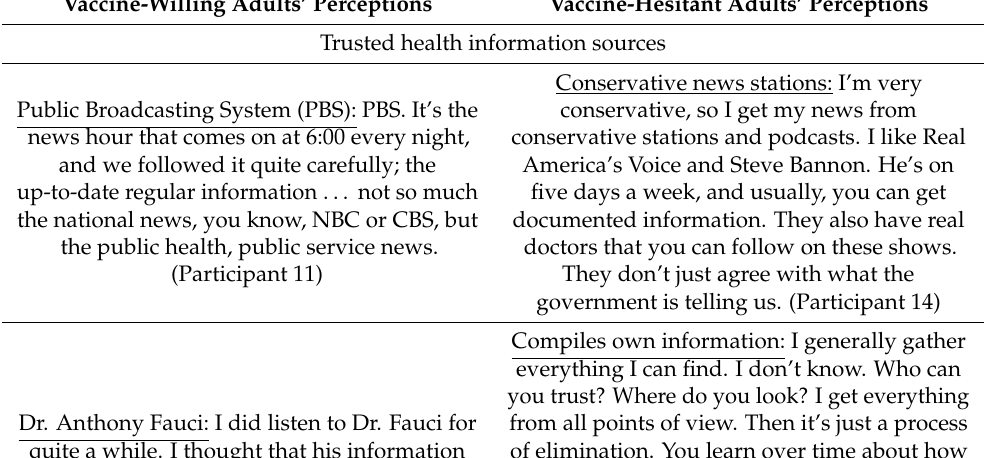
Table 4. Information sources and practices used by COVID-19 vaccine-hesitant and vaccine-willing